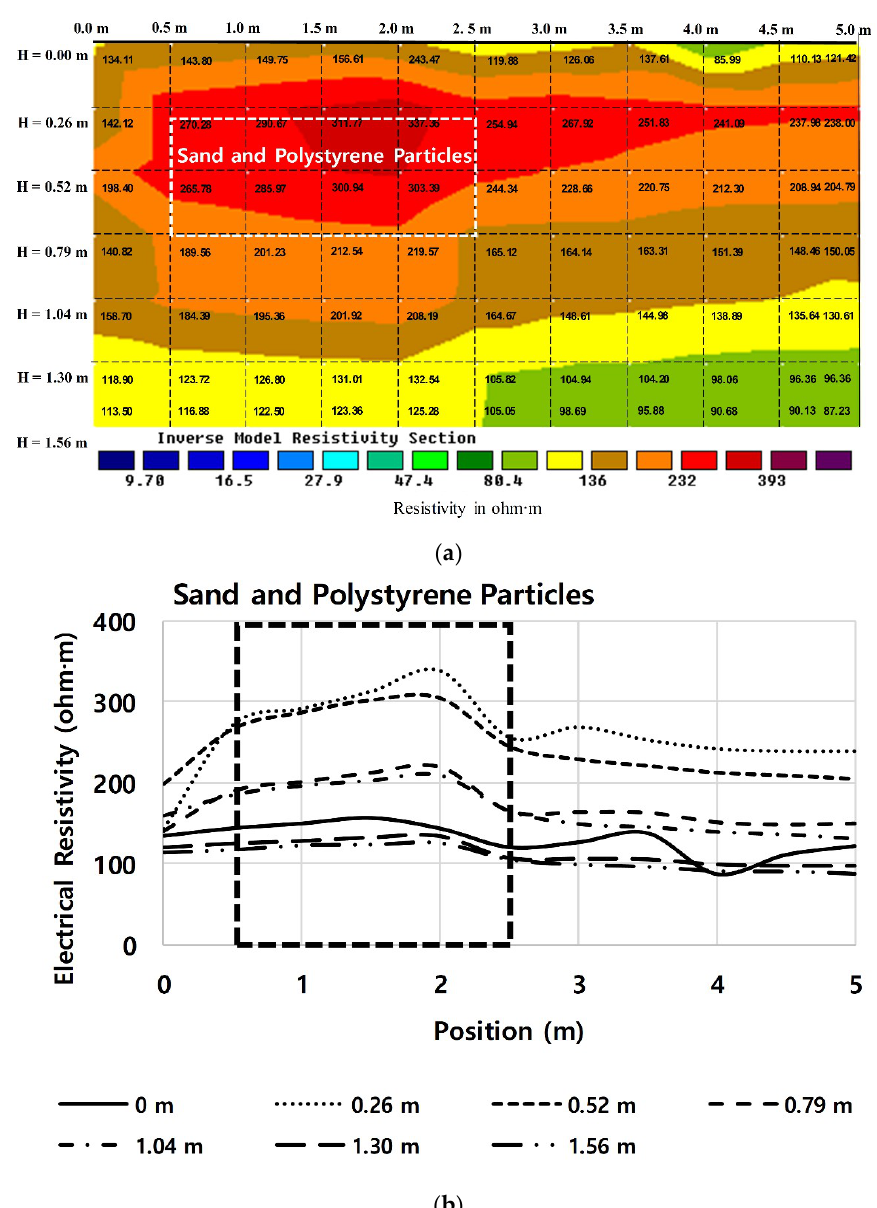
Figure 8. Test result for ground softening (Section No. 2) ( a ) Distribution of the ER. ( b ) ER according the position at each